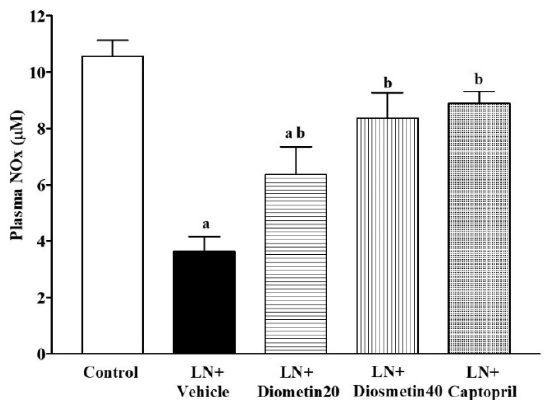
Figure 5. Effect of diosmetin and captopril on the plasma NOx concentration in LN-induced hy- pertensive rats. a p < 0.05 vs. control group, b p < 0.05 vs. LN + vehicle group. LN,